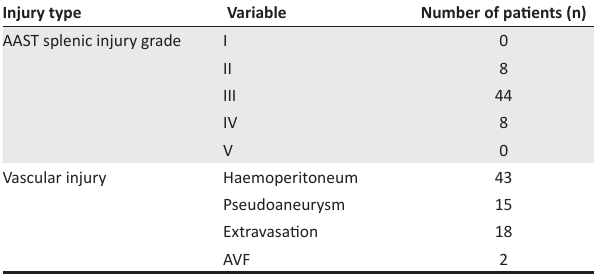
FIGURE 3: Fluoroscopic images demonstrating: (a) angiography of the main splenic artery showing pseudoaneurysm and arteriovenous fistula formation in the lower pole of the spleen and (b) combined distal and proximal coil embolisation. TABLE 1: Splenic injury grades and vascular injuries.